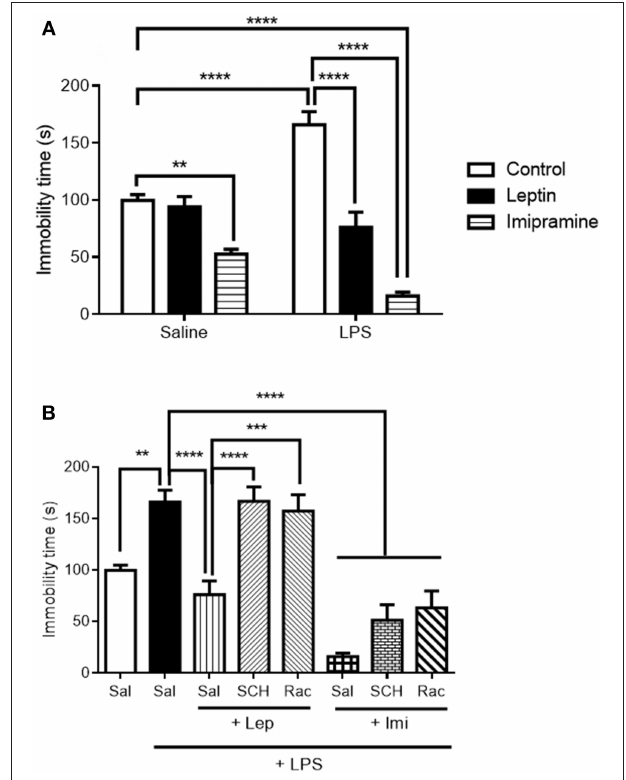
FIGURE 2 | Immobility time (s) in the forced swimming test (FST) of animals submitted to protocol 1 (A) and protocol 2 (B) . Bars represent mean ± standard error of the mean (S.E.M.) of 6–10 animals/group. The results in part A were analyzed by two-way ANOVA, while in part B by one-way ANOVA, in both cases with Tukey’s as post-hoc test. ** P < 0.01, *** P < 0.001, **** P < 0.0001 as indicated by the connectors. Sal, saline; SCH,